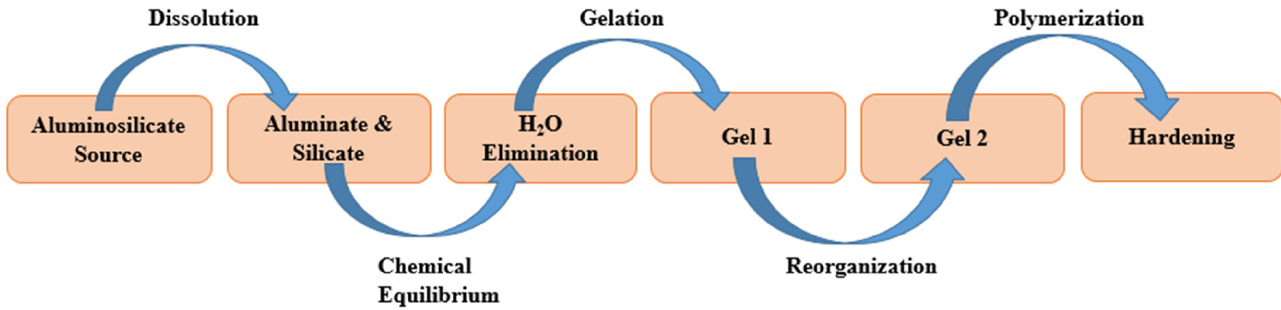
Figure 4. Alkali activation mechanism for low calcium precursors (Duxson’s model)